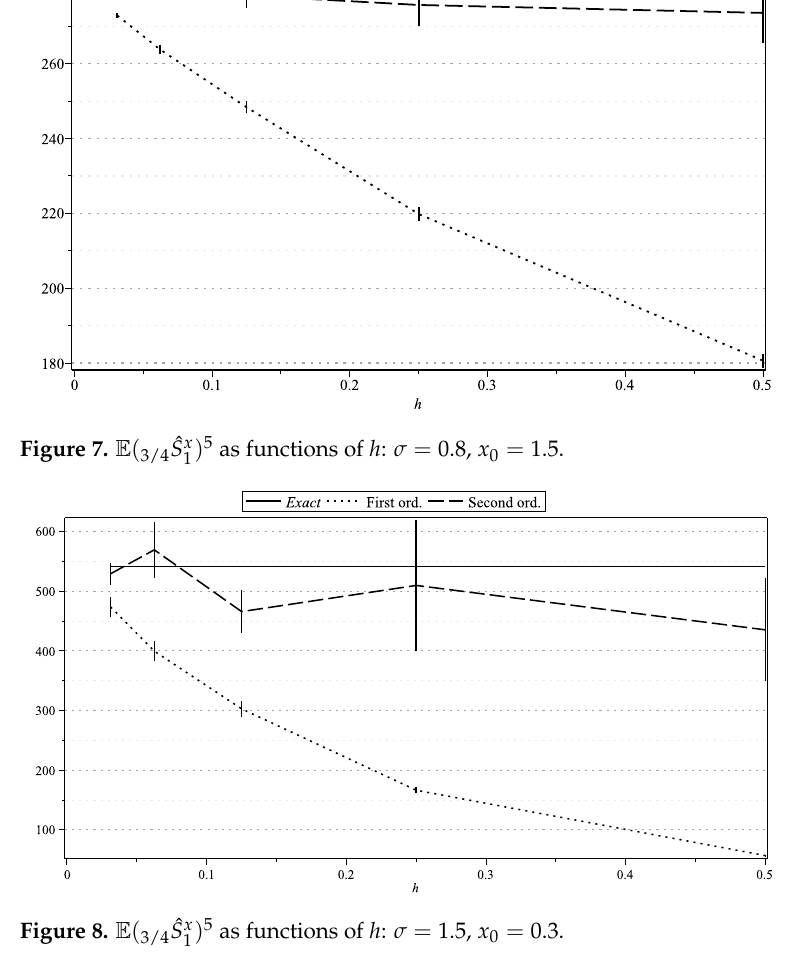
Figure 8. E ( 3/4 ˆ S x